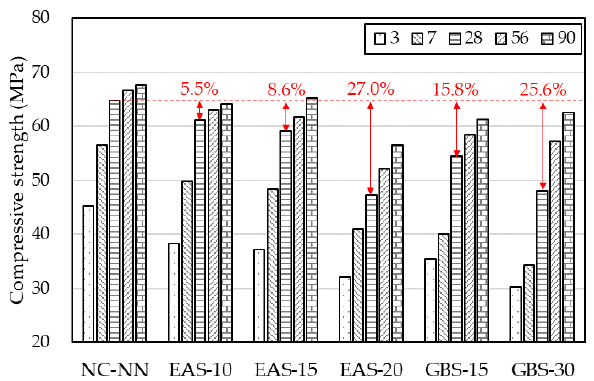
Figure 5. Test values for compressive strength.